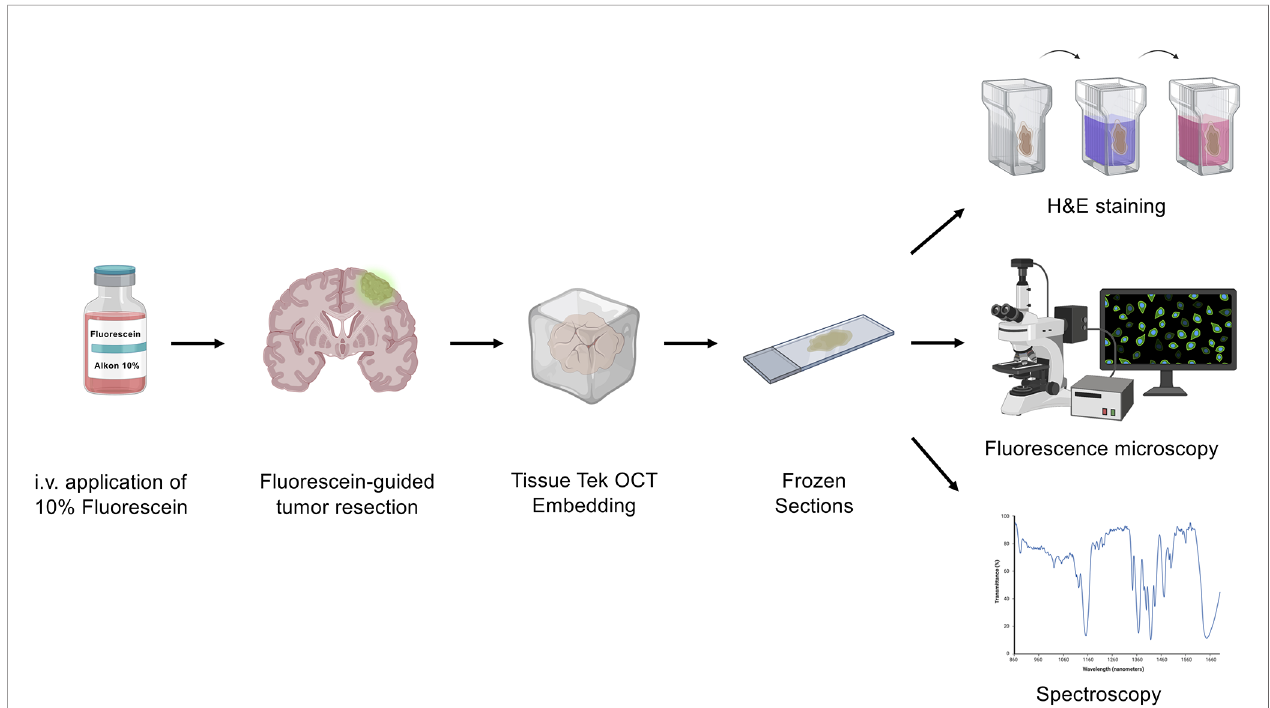
FIGURE 1 | Experimental work fl ow. Before tumor resection, patients received sodium fl uorescein (NaFl) intravenously (i.v.). After fi xation in 4% PFA and 30% sucrose immersion, the NaFl-stained tissue was embedded in Tissue-Tek OCT before cryosectioning. Frozen sections were then studied by fl uorescence microscopy and spectroscopy measurements.